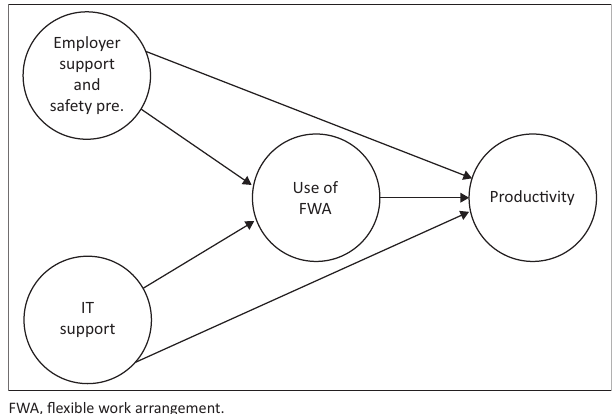
FIGURE 1: Use of flexible work arrangements in Africa during a